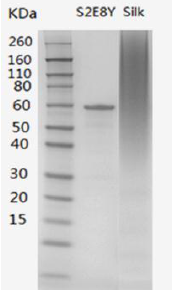
Figure 1. Sodium dodecyl sulfate polyacrylamide gel electrophoresis (SDS-PAGE) of purified S2E8Y and regenerated silk fibroin (SF).